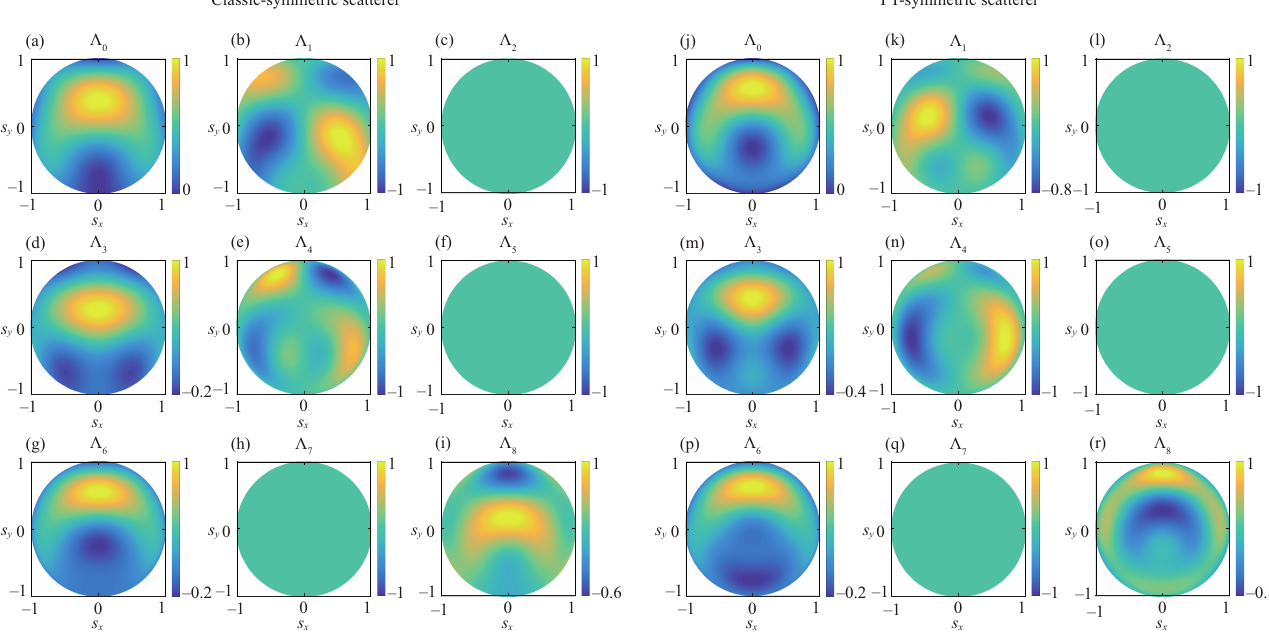
Figure 8. Simulation results for the nine generalized Stokes parameters of the far-zone scattered field generated by scattering the partially coherent radially polarized beam having degree of coherence shown in Equation (39) with a four-point scatterer having ( a – i ) classic-symmetric potential ( σ = 1 and γ = 0) and ( j – r ) PT-symmetric potential ( σ = 2 and γ = 1). The coherence parameters of the incident beam are α 1 = β 2 = α 3 = 0 and β 1 = α 2 = β 3 =